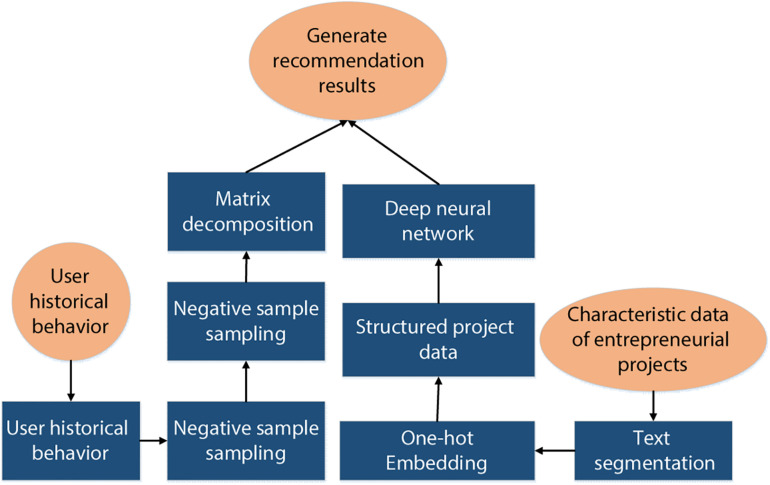
Flow diagram of entrepreneurial project recommendation algorithm.